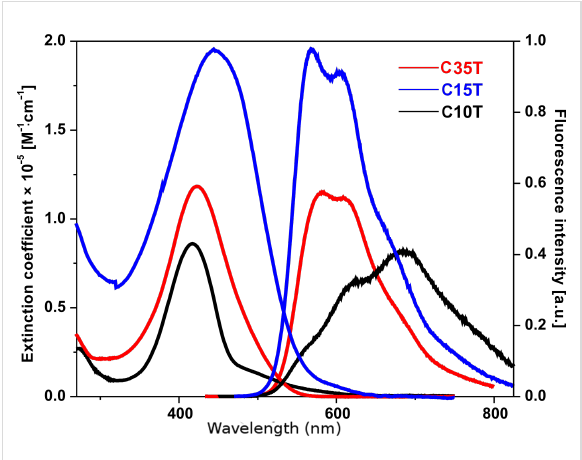
Figure 2: Representative absorption and fluorescence spectra of the smallest and largest macrocycles of series II in dichloromethane (taken from [28]). The excitation wavelength was chosen at the maximum of the absorption band.